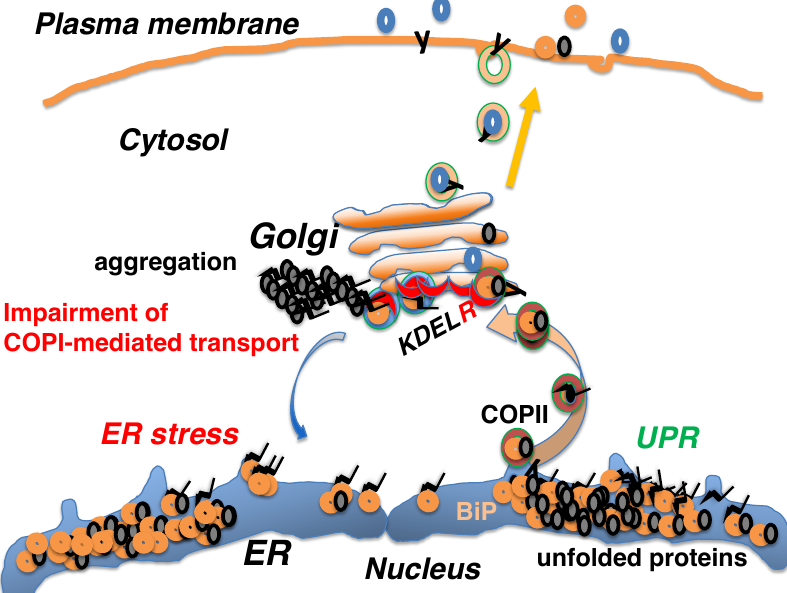
Figure 4. Dysfunction of COPI-mediated transport from the Golgi to the ER disrupts protein folding in the early secretory pathway, resulting in the accumulation of misfolded proteins and the subsequent induction of ER stress and the unfolded protein response